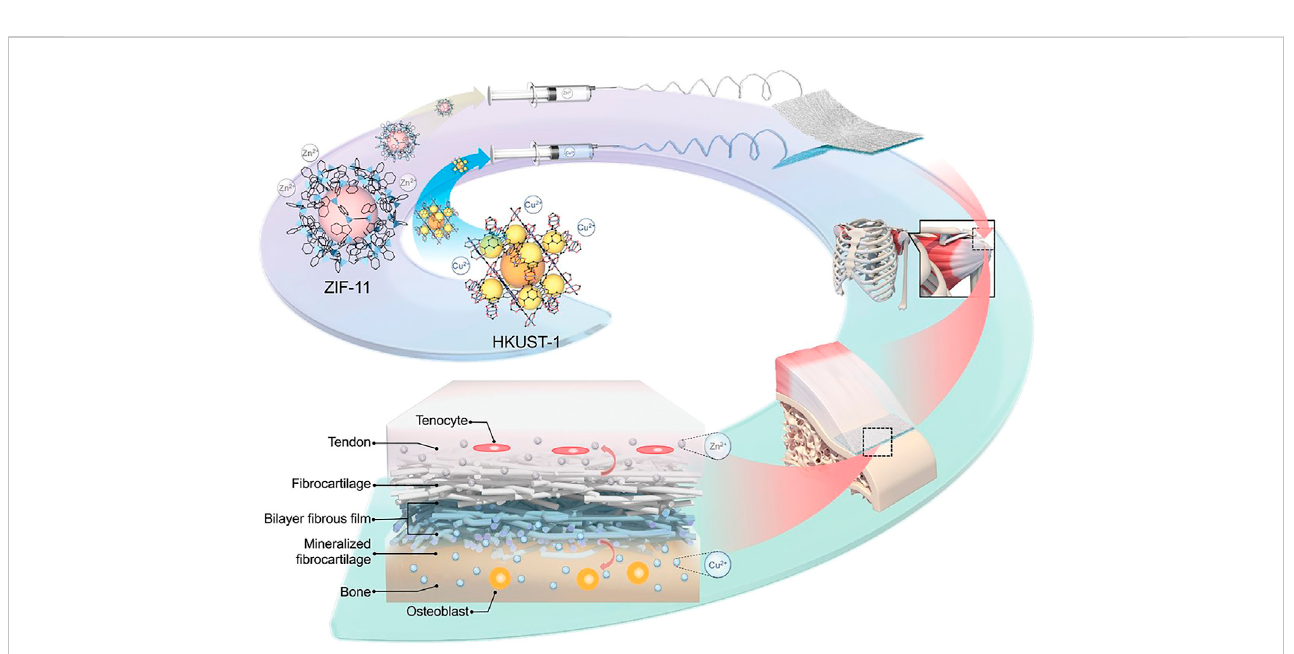
FIGURE 11 Schematic illustration of hybrid nano fi brous membrane fabrication and the effect of regulating the synchronous regeneration of the bone-tendon interface by metal ions released from the nano fi ber in situ (Yang et al., 2022) with the permission of Wiley Online Library.